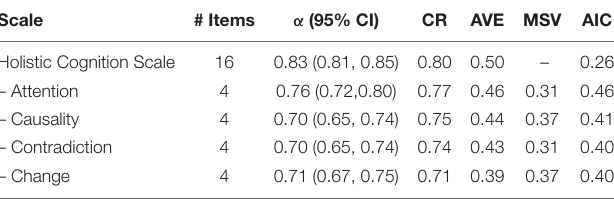
Sample 2, N = 454. α = Cronbach’s Coefficient Alpha. CI, confidence interval; CR, composite reliability; AVE, average variance extracted; MSV, maximum shared variance; AIC, average inter-item correlation.